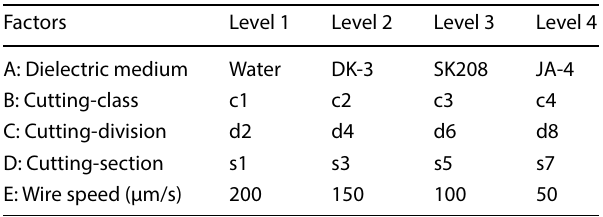
Fig. 1 Electric spark erosion powder making device ( a ) and processing track ( b